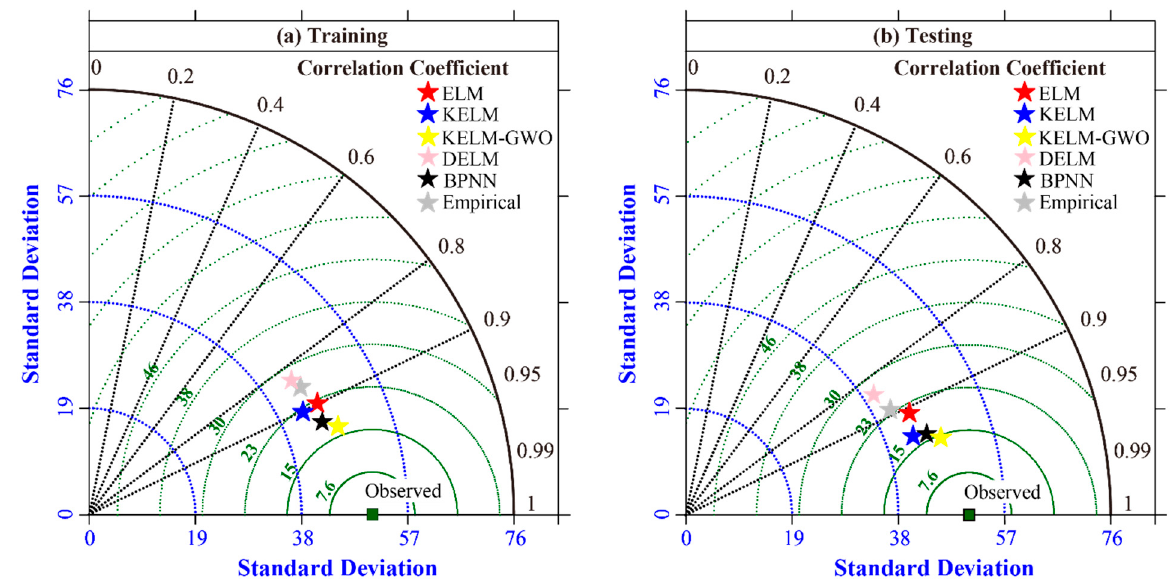
Figure 12. Graphical Taylor diagrams for the comparison of all models: ( a ) training phase; ( b ) testing phase. Table 6. Comparison between the current and previous works by using AI algorithms for UCS of rock